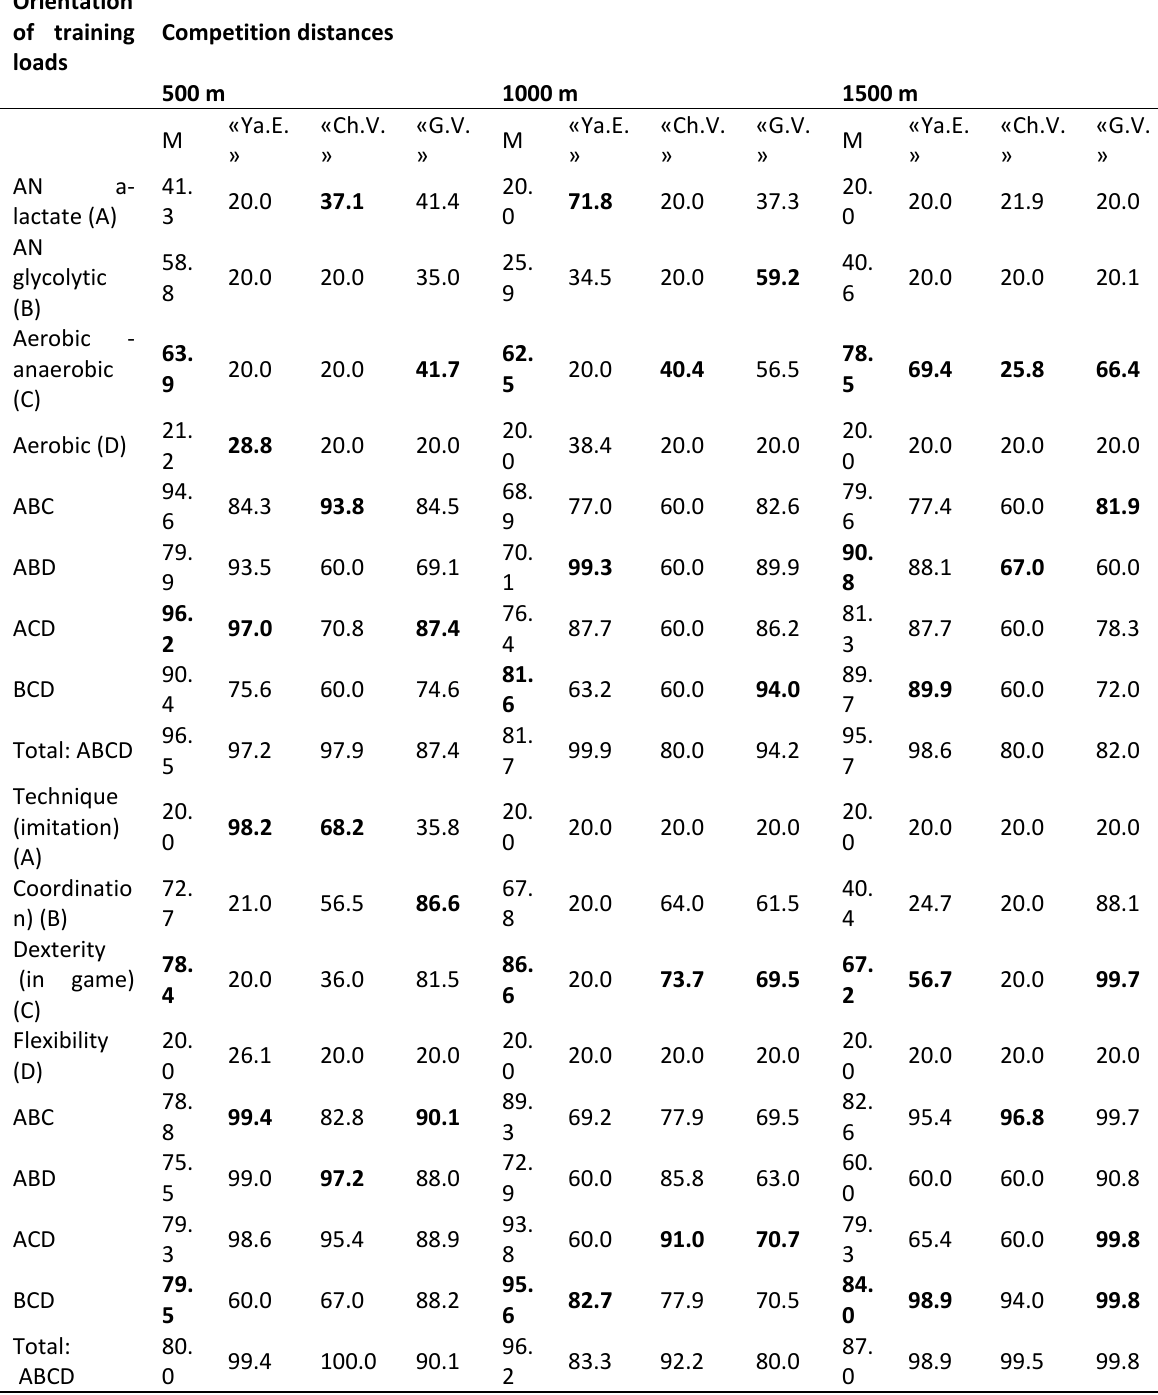
Table 2. Influence of a-cyclic loads’ main kinds on averaged and individual dynamic of leading Ukrainian short trackers’ sport results in 2000–2006 (r 2 ,%)